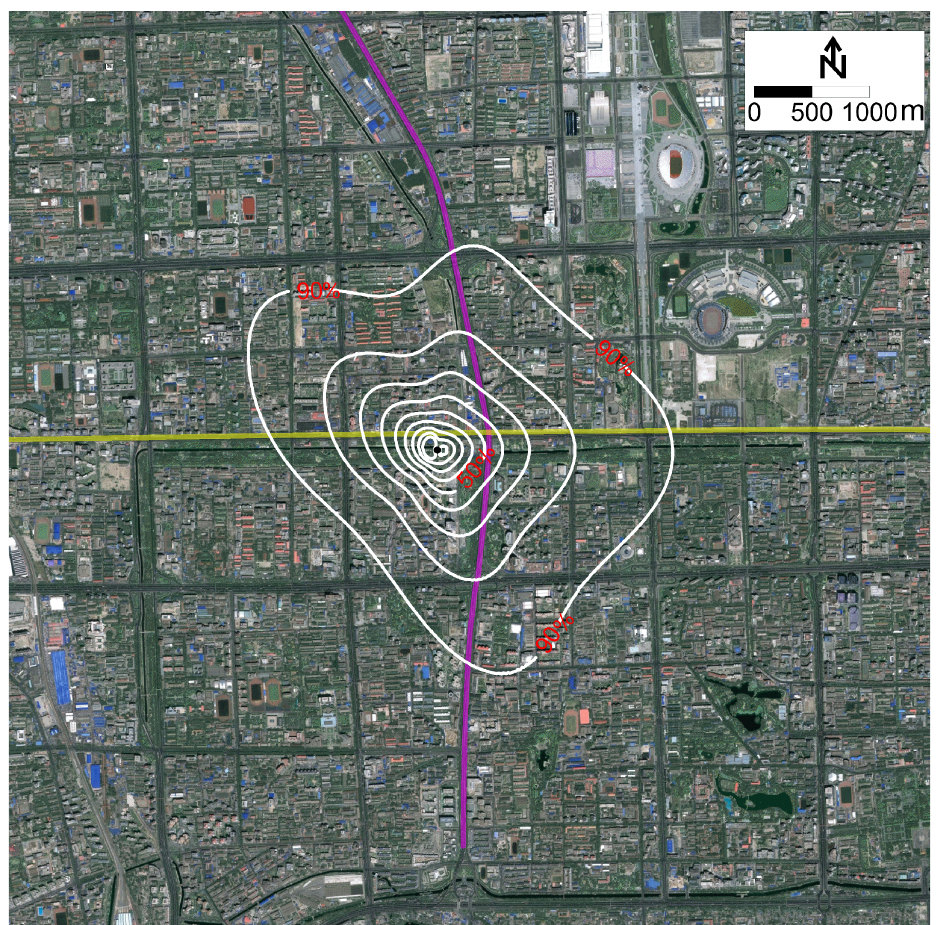
Fig. 1. Satellite photograph of the area around the measurement site taken from Google Earth. Source areas were calculated using the footprint model by Korman and Meixner (2001) from all half-hour data in 2006–2009. The white contours represent the percentage of the accumulated flux footprint within the contour. The black dot indicates the location of the tower. The purple line is the Beijing-Tibet Expressway, and the yellow line is the Beitucheng Road. The Yuan Dynasty Pelices Park is adjacent to the tower in the